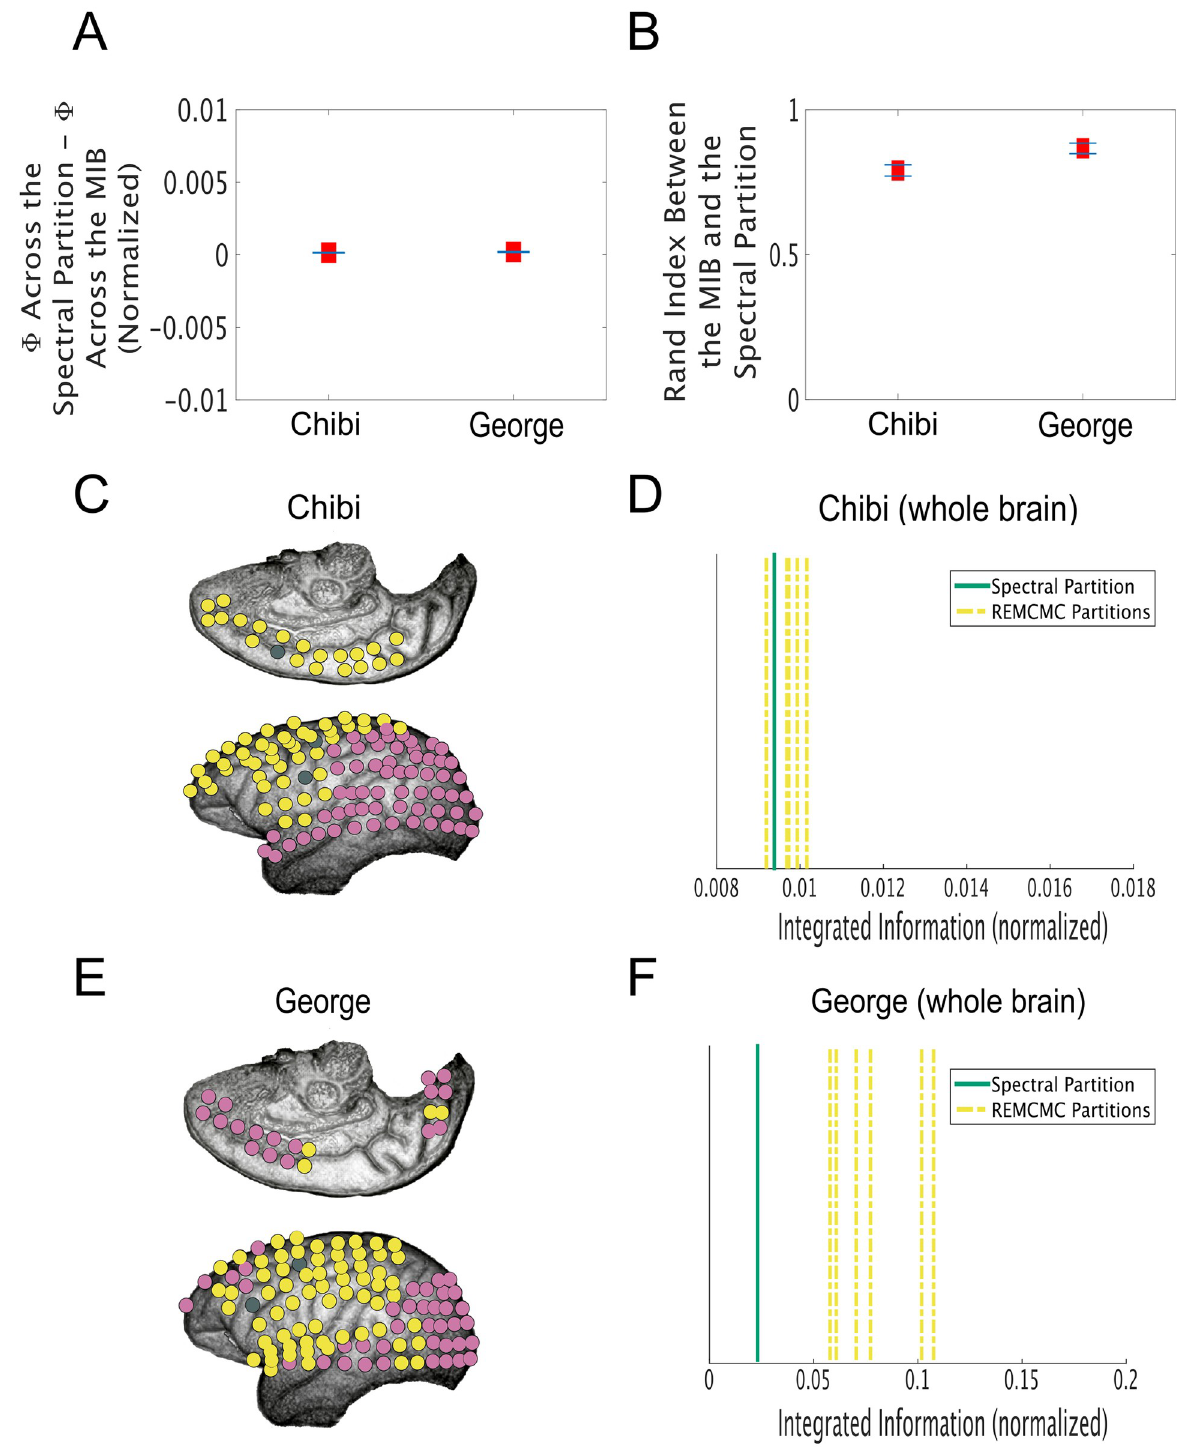
Fig 4. A We split the available ECoG electrodes in two macaque monkeys into overlapping sets of 14 electrodes. The ground-truth MIB of 14 electrodes can be identified through a brute-force search, and compared to the spectral partition estimated from the correlation matrix of data from those electrodes. Here, we subtracted F G (normalized) across the ground-truth MIB from F G (normalized) across the spectral partition. There was a difference of 0 bits for 67/112 (mean difference = 0.0002 bits) datasets from George’s brain, and a difference of 0 bits in 46/112 (mean difference = 0.0001 bits) datasets from Chibi’s brain. Red squares indicate the mean difference in F G (normalized) across all datasets from one